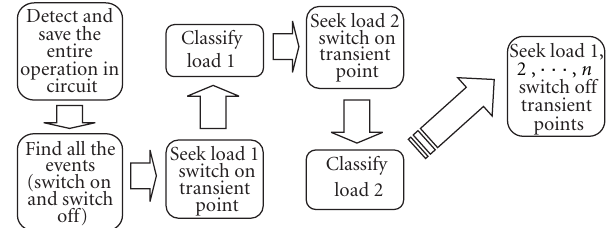
Figure 1: The load events detection